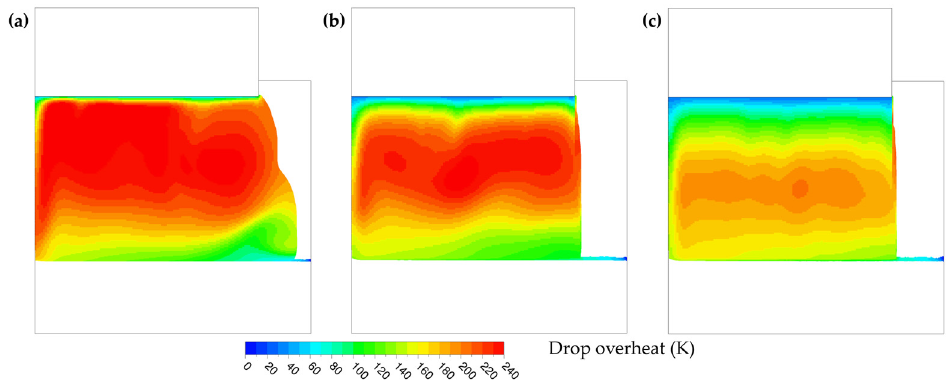
Figure 14. Drop overheat (time-averaged) considering the fall of 1 ( a ), 5 ( b ) and 10 mm ( c ) drops.